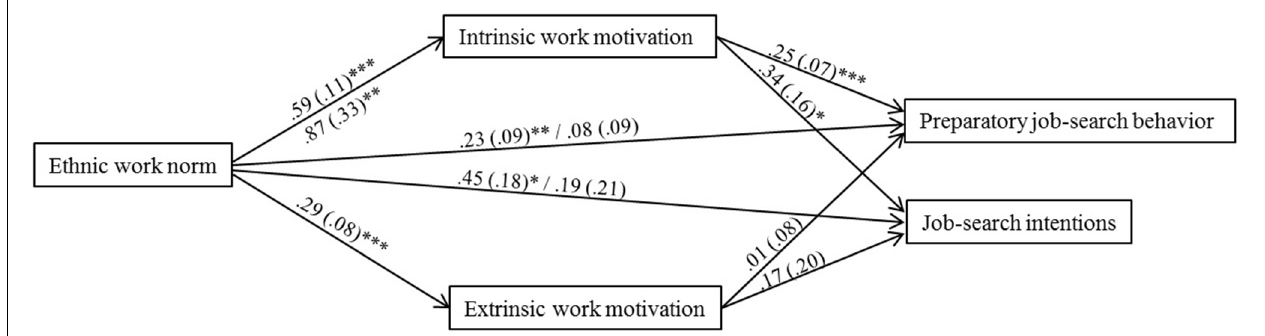
FIGURE 2 | Differential sensitivity to contextual influence among overcontrollers. Unstandardized estimates [ b ( SE )] above arrows apply to undercontrollers and resilients; unstandardized estimates below arrows apply to overcontrollers. If these estimates did not significantly differ, estimates for